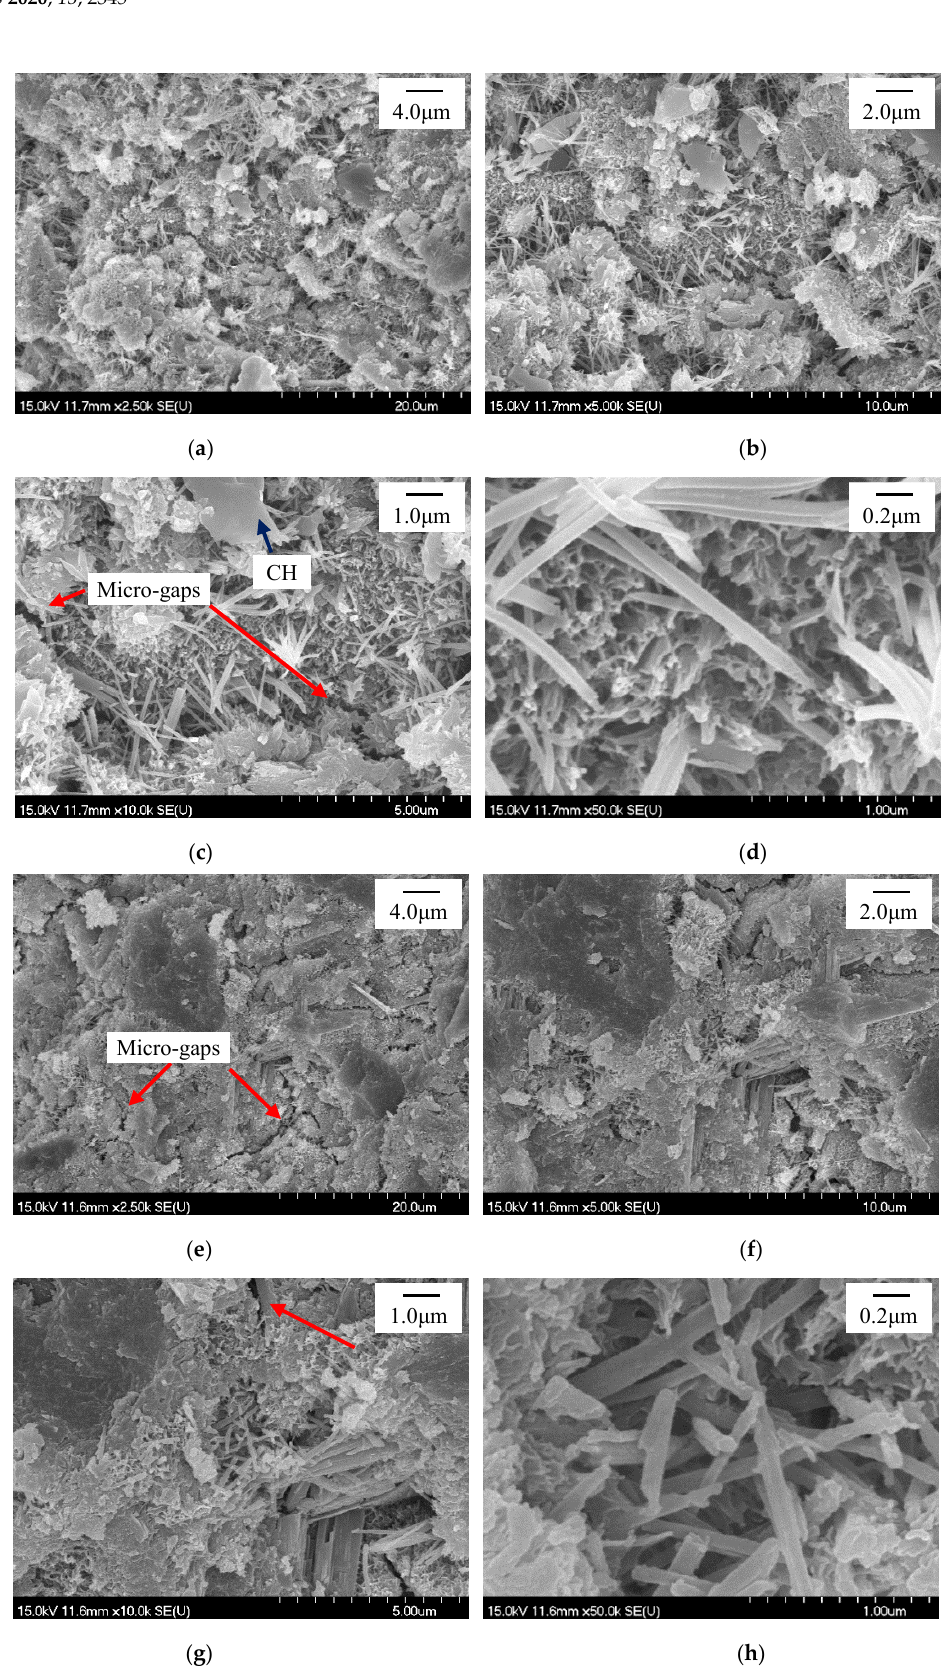
Figure 13. SEM photographs for the HCP with 0.2 wt.% Sucrose at T2 and T3. ( a )–( d ) T2, ( e )–( h ) T3.